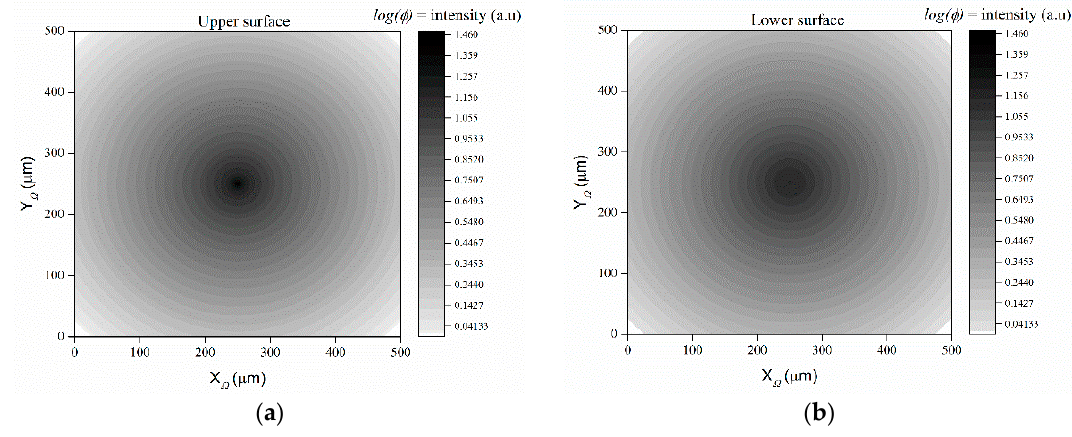
Figure 9. Comparisons among Net ROD values (obtained experimentally by Chun et al. [8] and from theoretical predictions with two different mass energy-absorption coefficients, ( µ α ) m ) versus UV-light exposures. (The error bars for the experimental data are smaller than the symbols.).